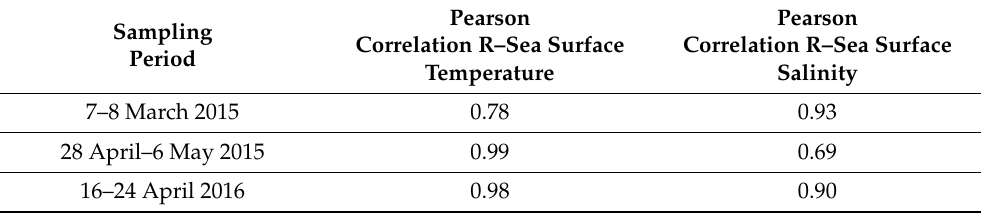
Table 4. Correlation between same variables obtained remotely and by M/V Equinox [ID: MLCE; 7 March 2015 to 6 November 2016] cruise-segmented datasets. Their p -value is <0.00001 and all of the correlations are significant at p < 0.05.